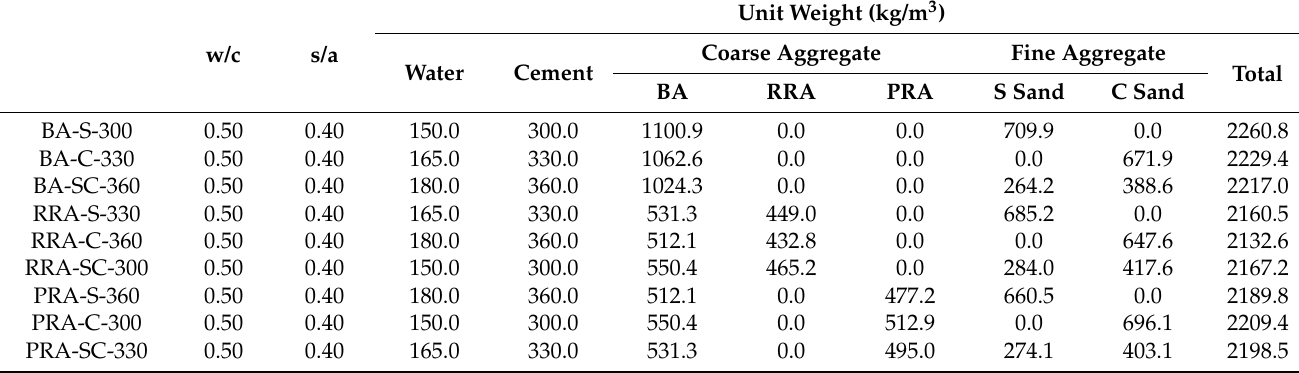
Table 2. Mix proportion of the concrete.